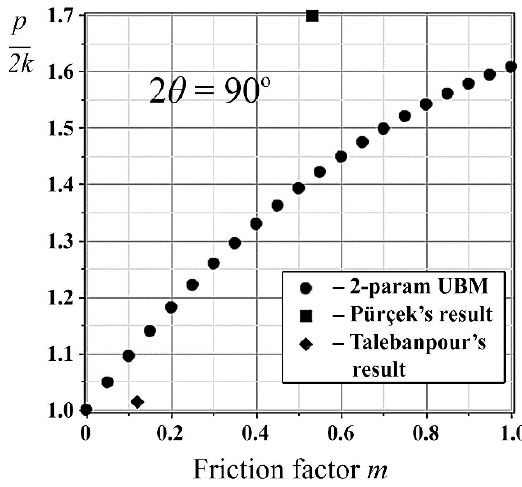
Figure 10. Comparison of theoretical results for relative punching pressure p/2k derived with two-parameter UBM for non-hardening metal flow through a Segal die with channel intersection angle 2θ=90° with published experimental results for relative punching pressure p/2k : ●●●●● – computational two-parameter UBM result calculated according to (3)-(4), and (6); ■ – G. Pürçek experiment (results divergence is δ ( p/2k )= 16.48% [32] ); ♦ – B. Talebanpour G. Pürçek experiment (results divergence is δ ( p/2k )= 9.76% [27] B. Talebanpour